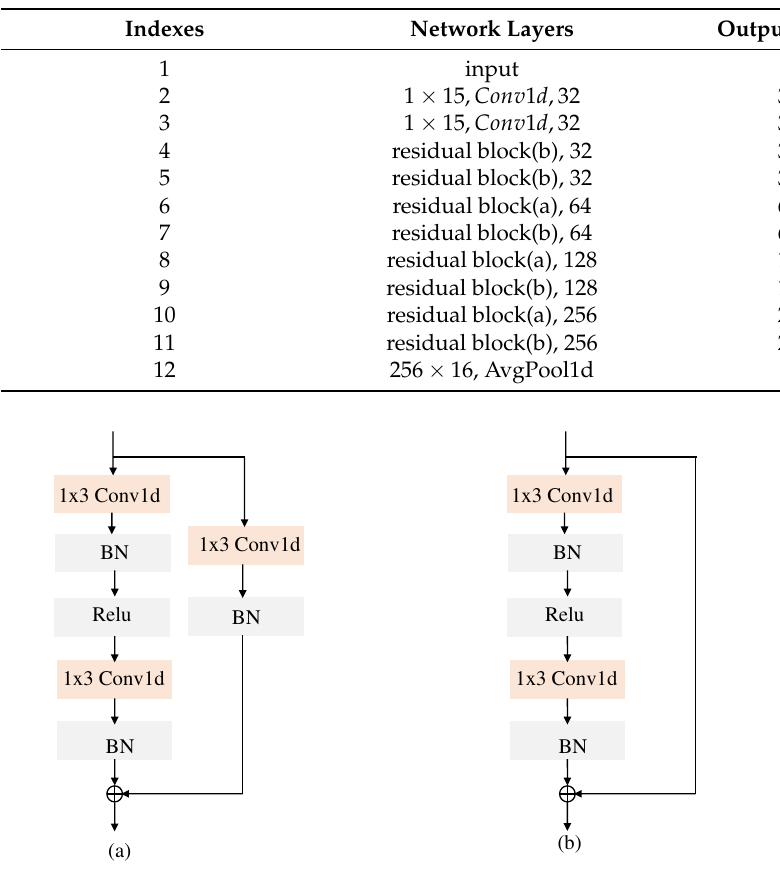
Table 2. Residual network structure.